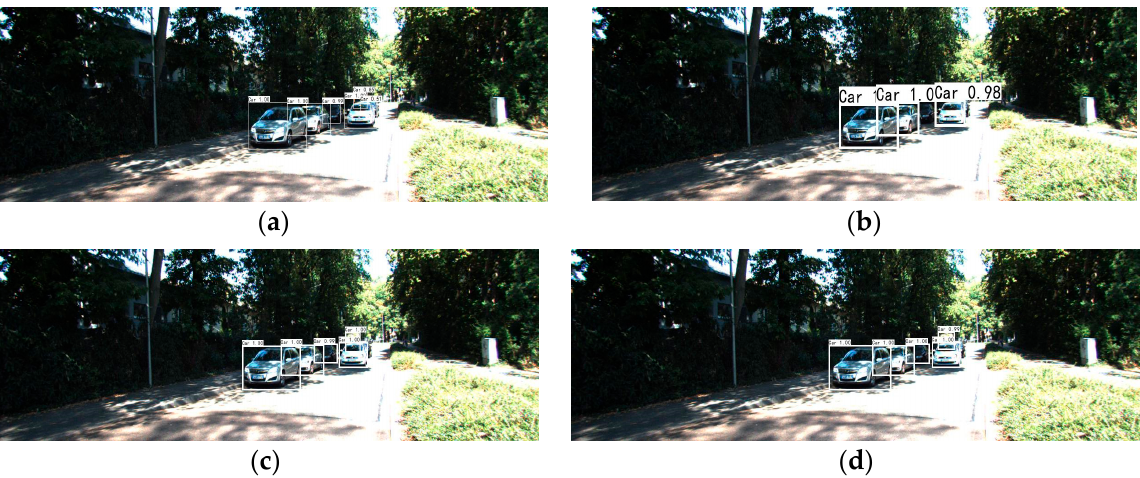
Figure 10. Complex scenes. ( a ) Faster R-CNN detection e ff ect, ( b ) SSD detection e ff ect, ( c ) YOLOv3